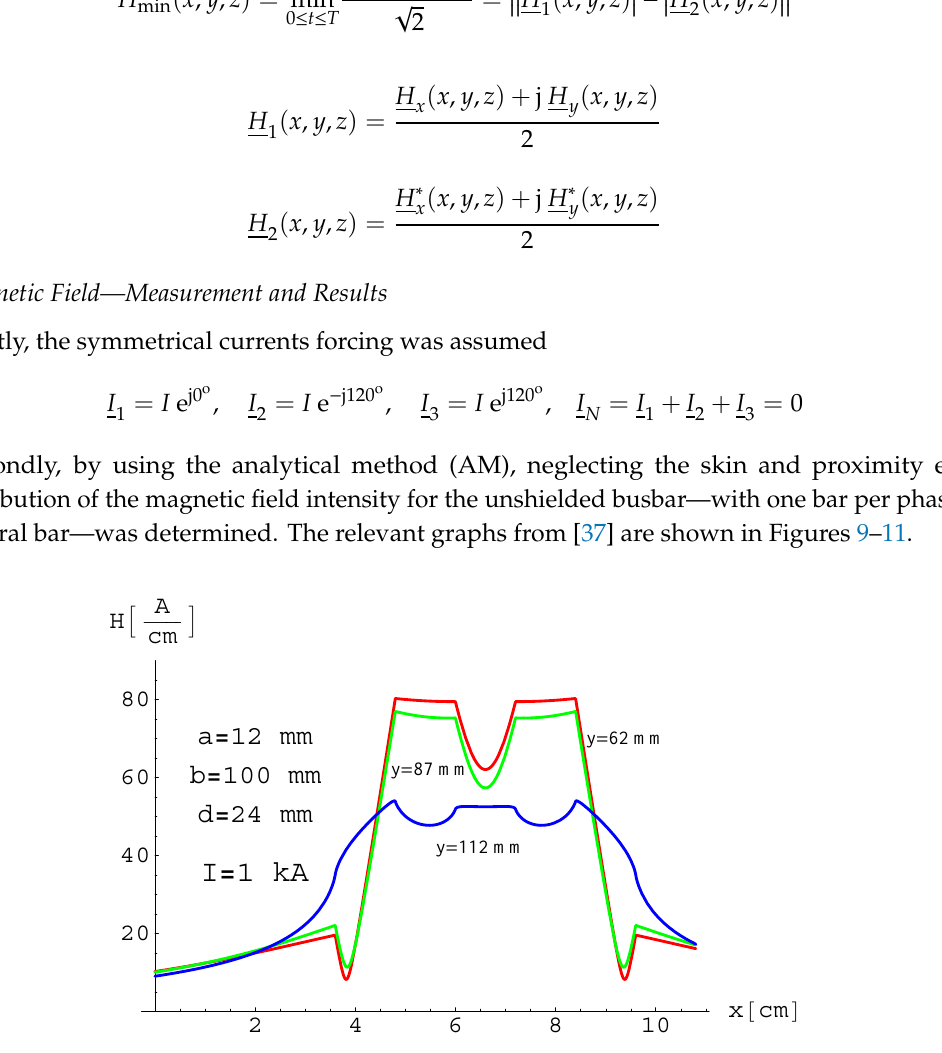
Figure 9. The distribution of magnetic field intensity along the line y = const (constants) of an unshielded busbar system with current symmetry.